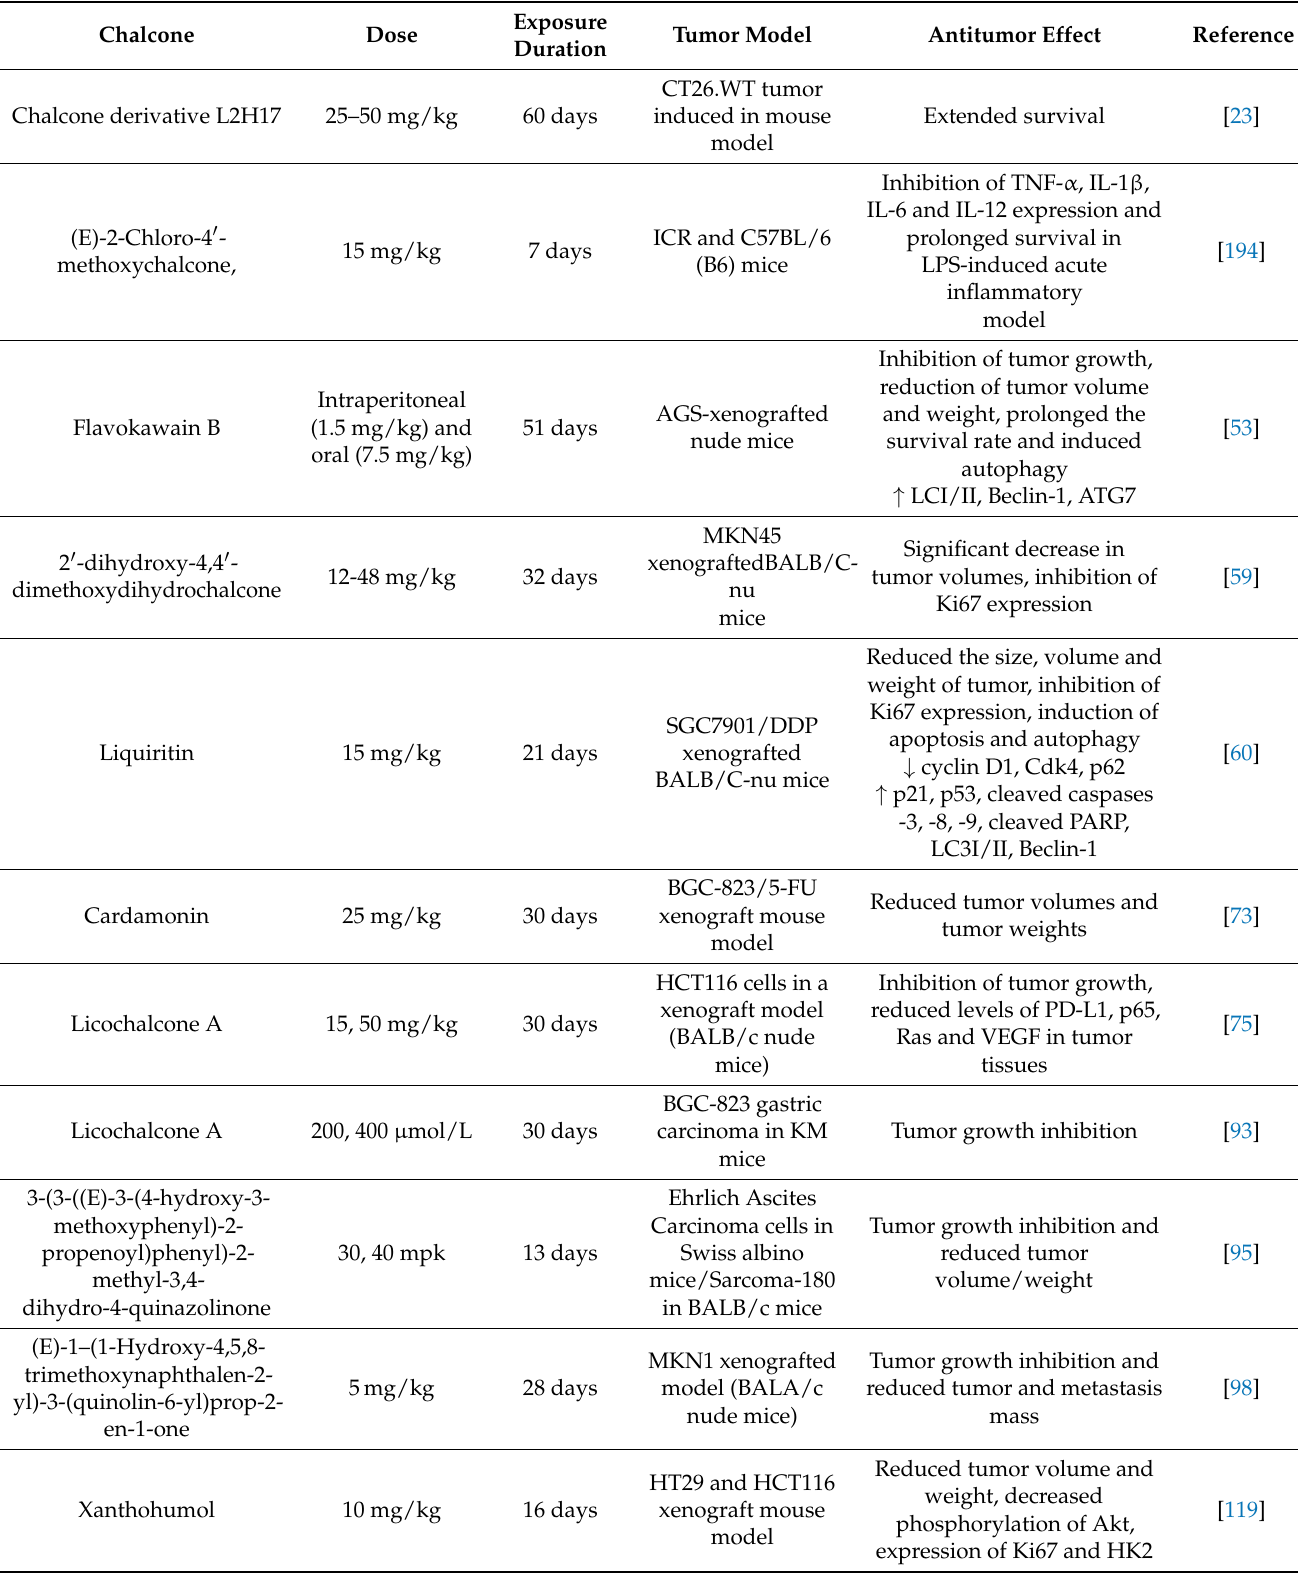
Table 2. In vivo antitumor effect of selected